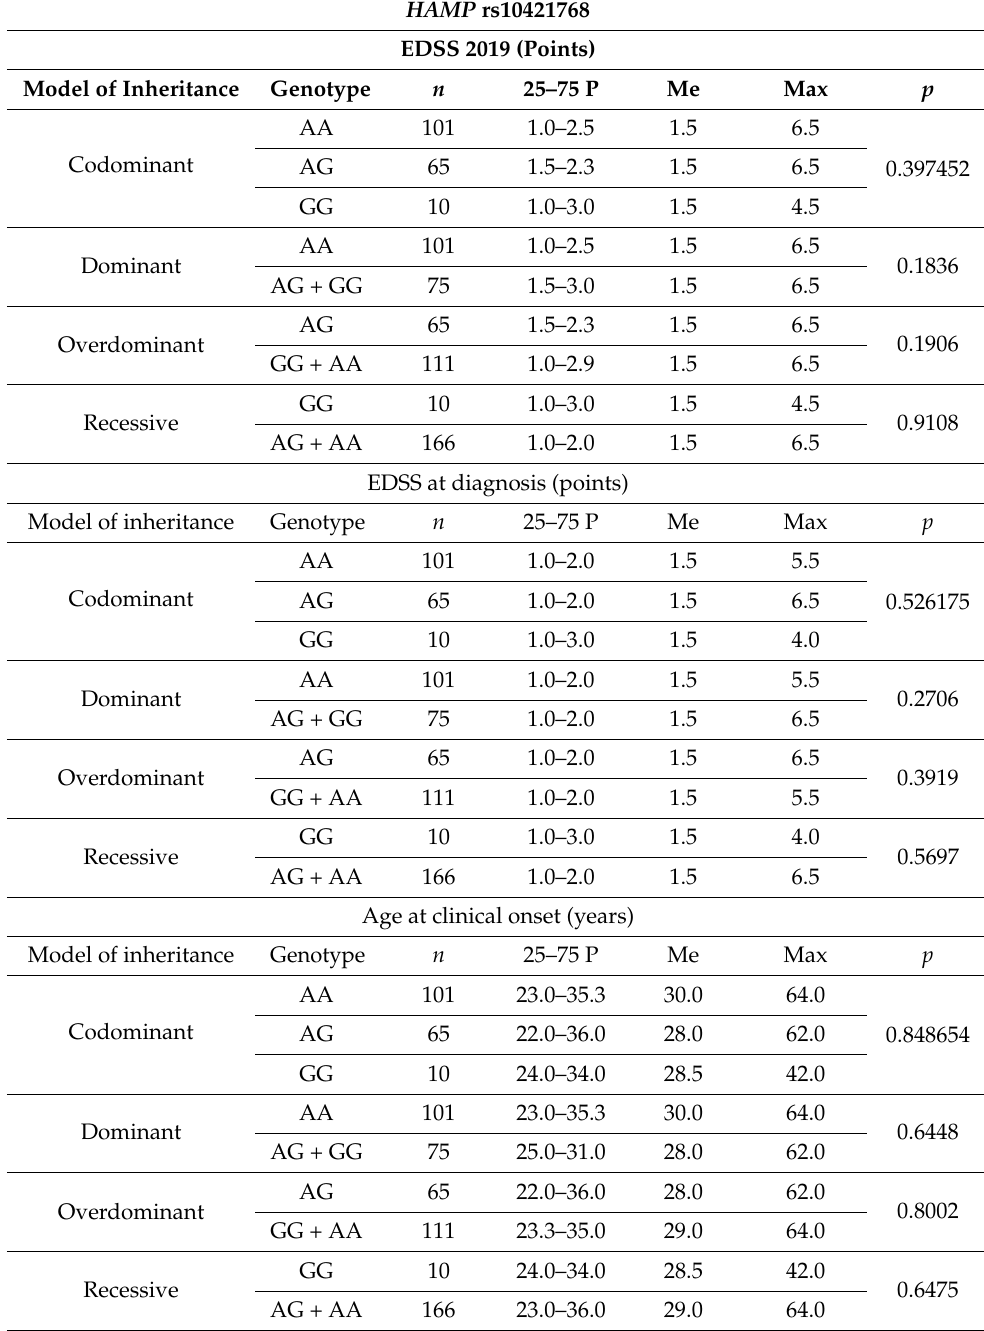
Table 4. Analysis of the relationship between the rs10421768 HAMP polymorphism and selected clinical